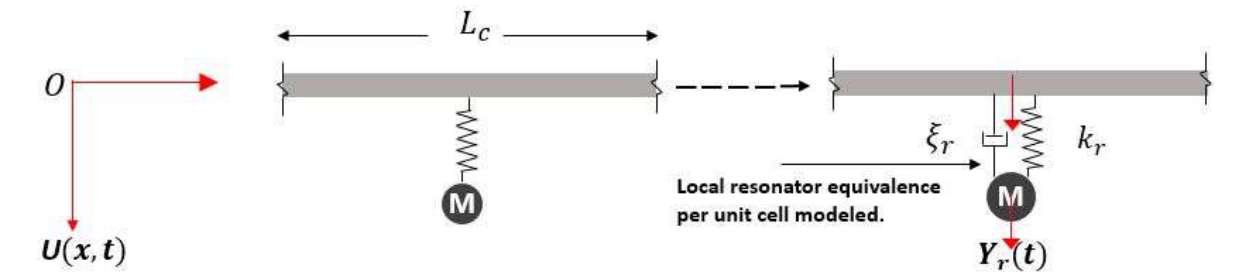
Figure 2. Schematic representation of the unit cell and the local resonator as typically modeled. L c represents the length of each unit cell.